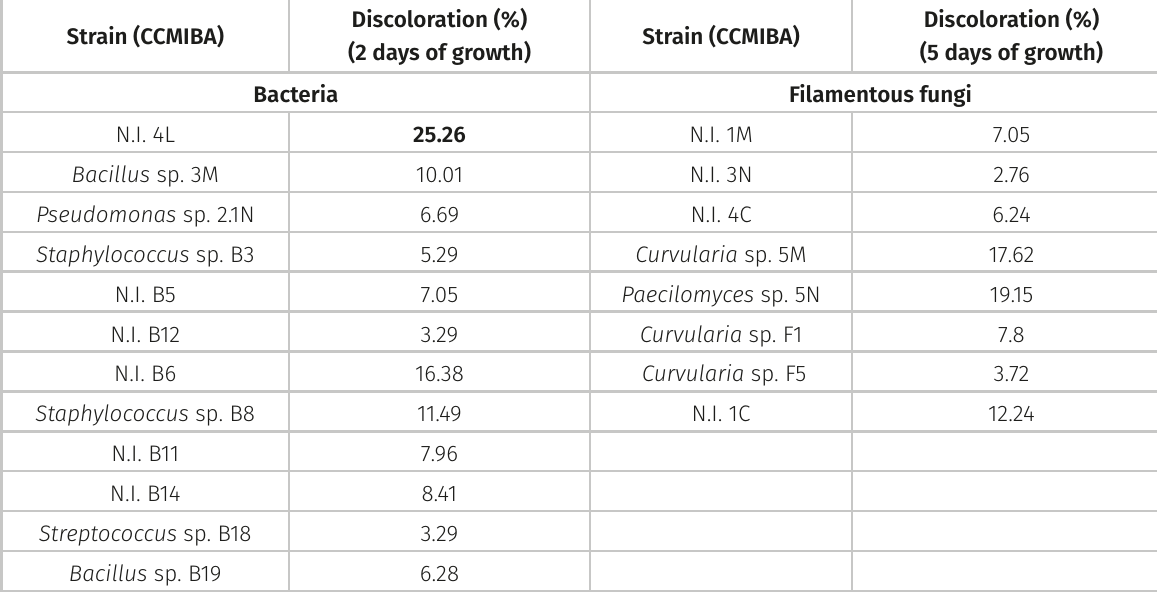
Table III. Discoloration of leachate as the only source of nutrient. Strain